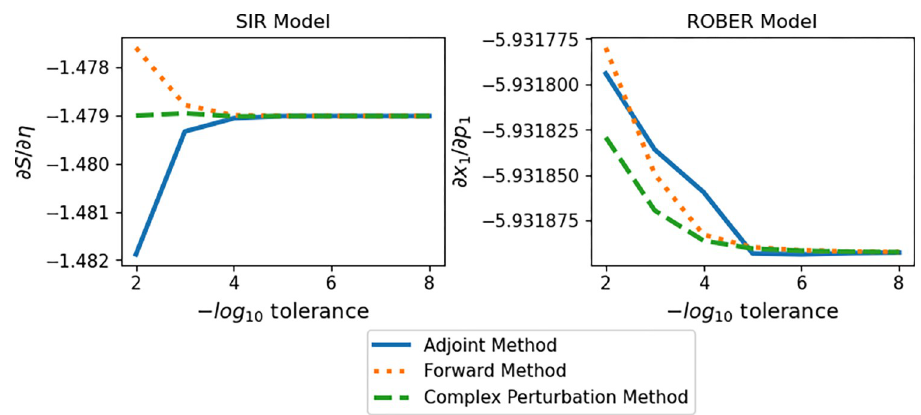
Fig 6. Convergence of Adjoint, Forward, and Complex Perturbation Methods for Numerical Sensitivities. Convergence plot of the SIR model (left) and ROBER model (right) simulated over t = 1000 days. For SIR the initial conditions are S 0 = 3.4 × 10 8 , and I 0 = 100, and the parameters are η = 0.7194 and δ = 0.5025. For ROBER the initial conditions are x 1 = 1.0, x 2 = 0.0, and x 3 = 0.0, and the parameters are p 1 = 4 × 10 − 2 , p 2 = 3 × 10 7 , and p 3 = 1 × 10 4 . First- order sensitivities are computed via code from this manuscript (complex perturbation method), the ForwardDiff.jl package (forward method), and the Rodas4(autodiff = false) solver under the QuadratureAdjoint (autojacvec = EnzymeVJP()) sensealg protocol in the DiffEqSensitivities.jl package (adjoint method). The adjoint method requires a step size of 1.0 for the SIR model and a step size of 0.1 in the ROBER model to converge. All results are normalized by the number of time steps included in the simulation. https://doi.org/10.1371/journal.pcbi.1009598.g006 between the derivatives calculated at various error tolerances and the derivatives calculated at a strict tolerance of 1 × 10 − 8 (for the SIR model) and 1 × 10 − 5 (for the ROBER model). We chose these tolerances as the strictest possible that are numerically realistic for each model. Fig 6 demonstrates that our choices are strict enough for the methods to reach convergence. We dis- play errors versus time in a log-log plot averaged over compartments and parameters and nor- malized by length of time. We do not include the adjoint method in this comparison due to its difficulties in convergence and large computational cost.